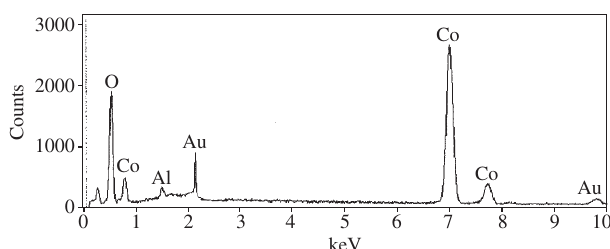
Figure 5. EDX spectra of Co nanowire.